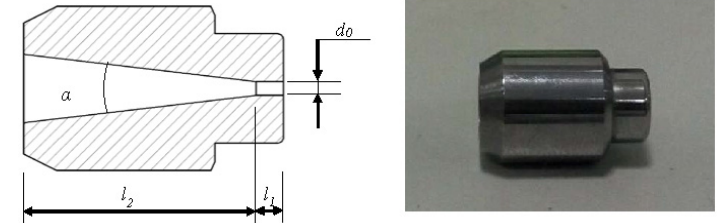
Figure 3. Schematic diagram of the convergent nozzle.